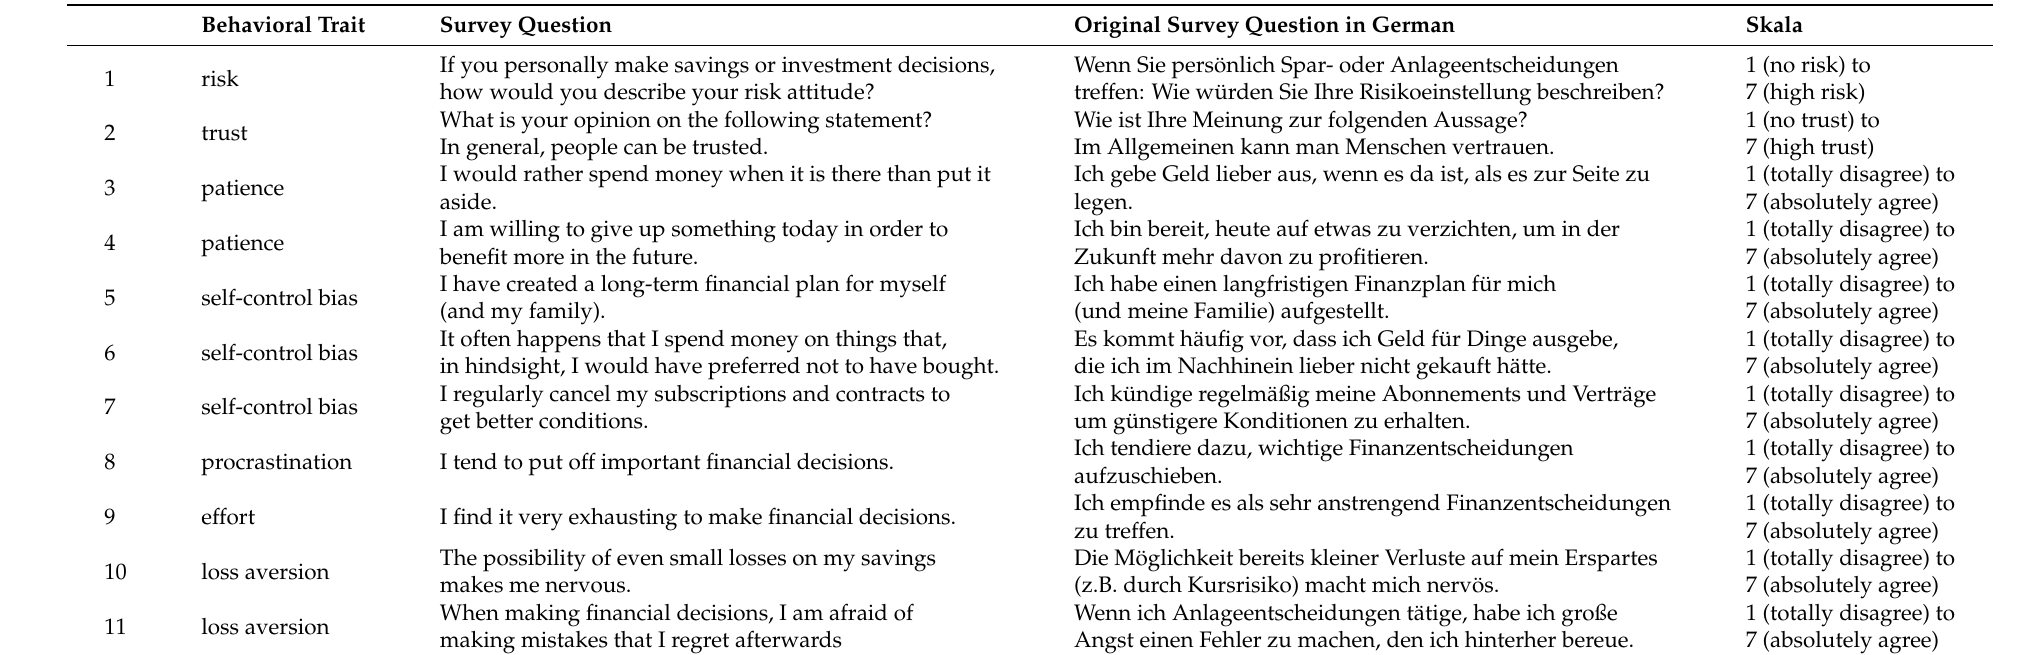
Table A5. Survey questions. Source: Own